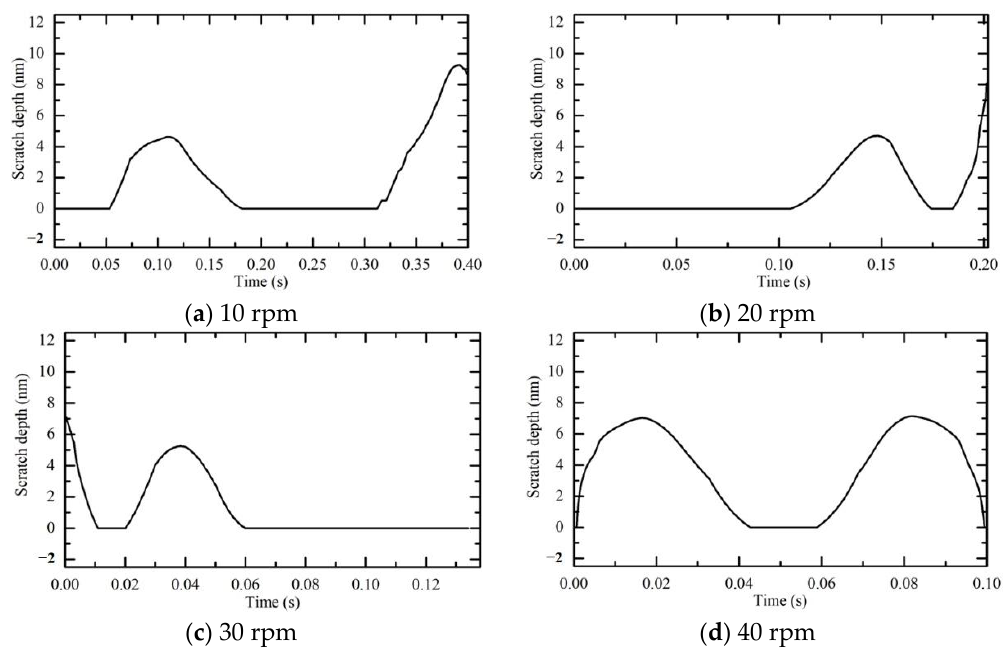
Figure 21. Scratch damage depth with different polishing disc speeds.